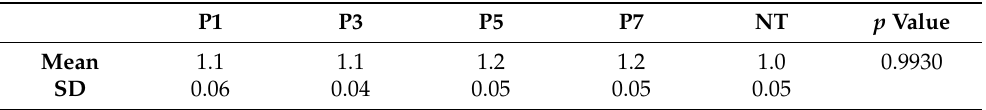
Table 1. Mean and standard deviation (SD) of DNA index (DI) obtained for OBA-9 cells exposed to He-CAPP for 1, 3, 5, and 7 min (P1 to P7).